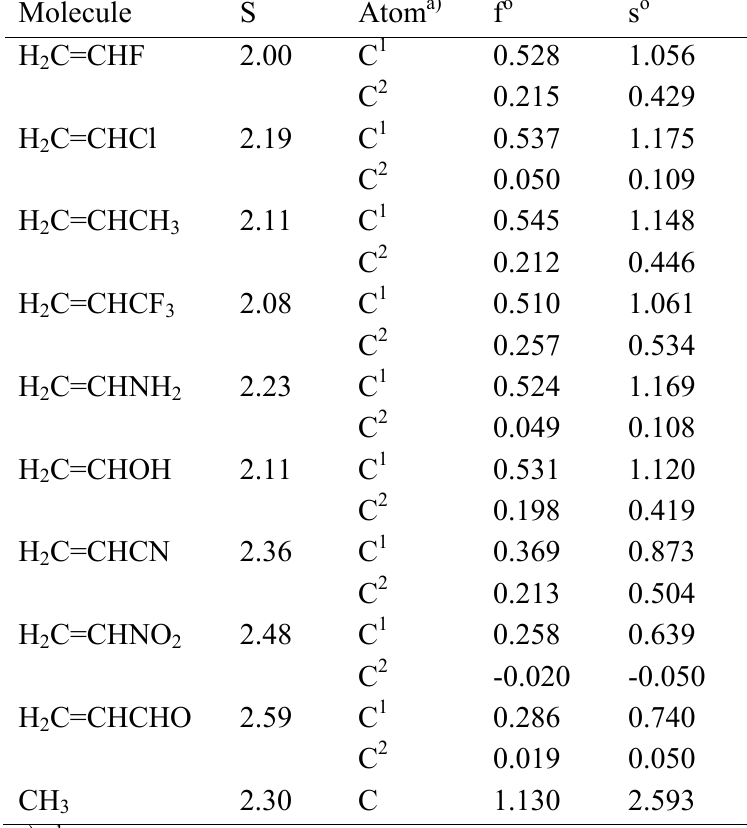
Table 1 . The condensed Fukui function (f o ) and softness (s o ) for radical attack of the two carbon atoms of substituted olefins. The calculations were performed by using B3LYP in conjunction with 6- 31G(d,p) basis set and Fukui functions were estimated from the electrostatic potential (ESP) derived atomic